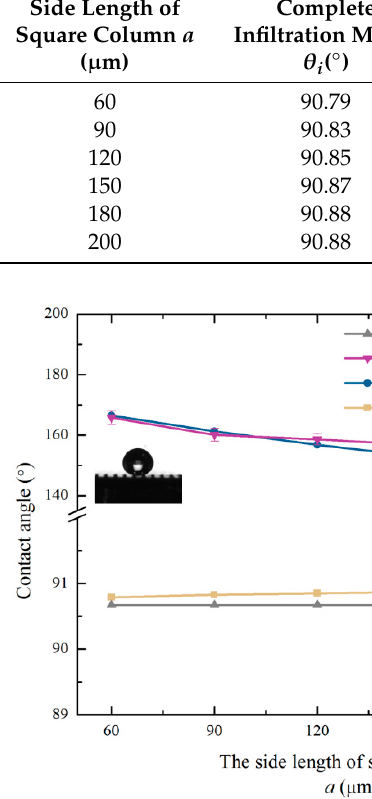
Figure 7. Variation curve of the contact angle between measurement and theory.